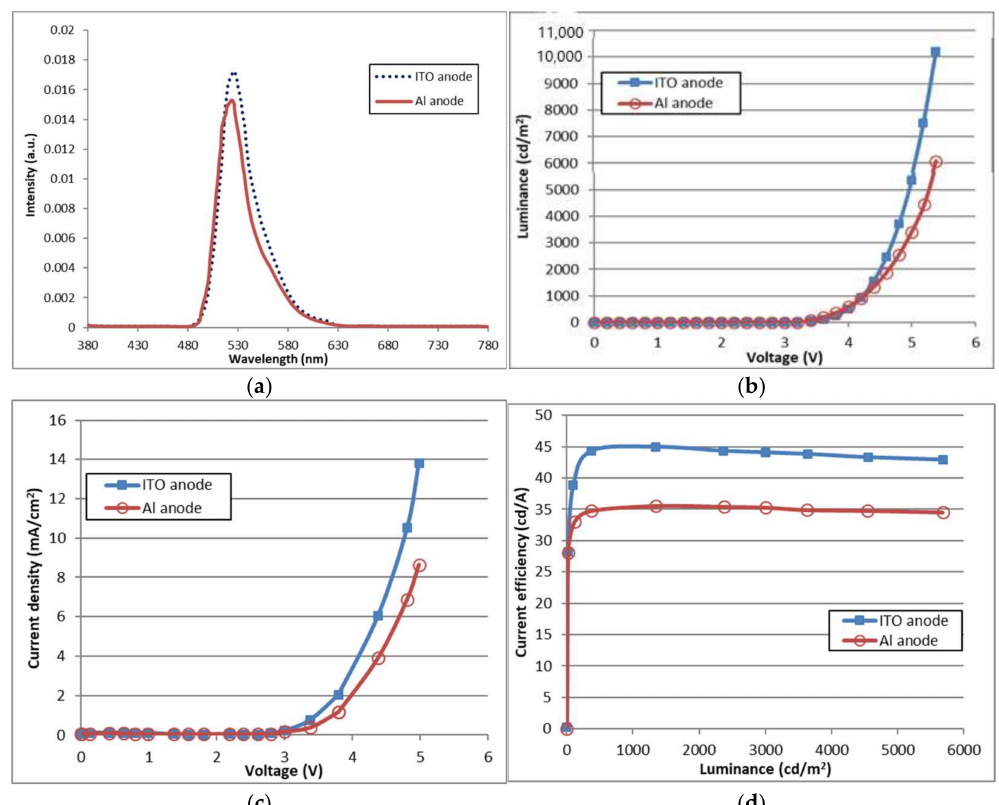
Figure 2. Characteristics of OLED devices with Al anode and HATCN HIL: ( a ) Electroluminescence spectrum of the OLED devices; ( b ) Characteristics of luminance for different voltages; ( c ) Characteristics of current density for different voltages; and ( d ) Characteristics of current efficiency for difference